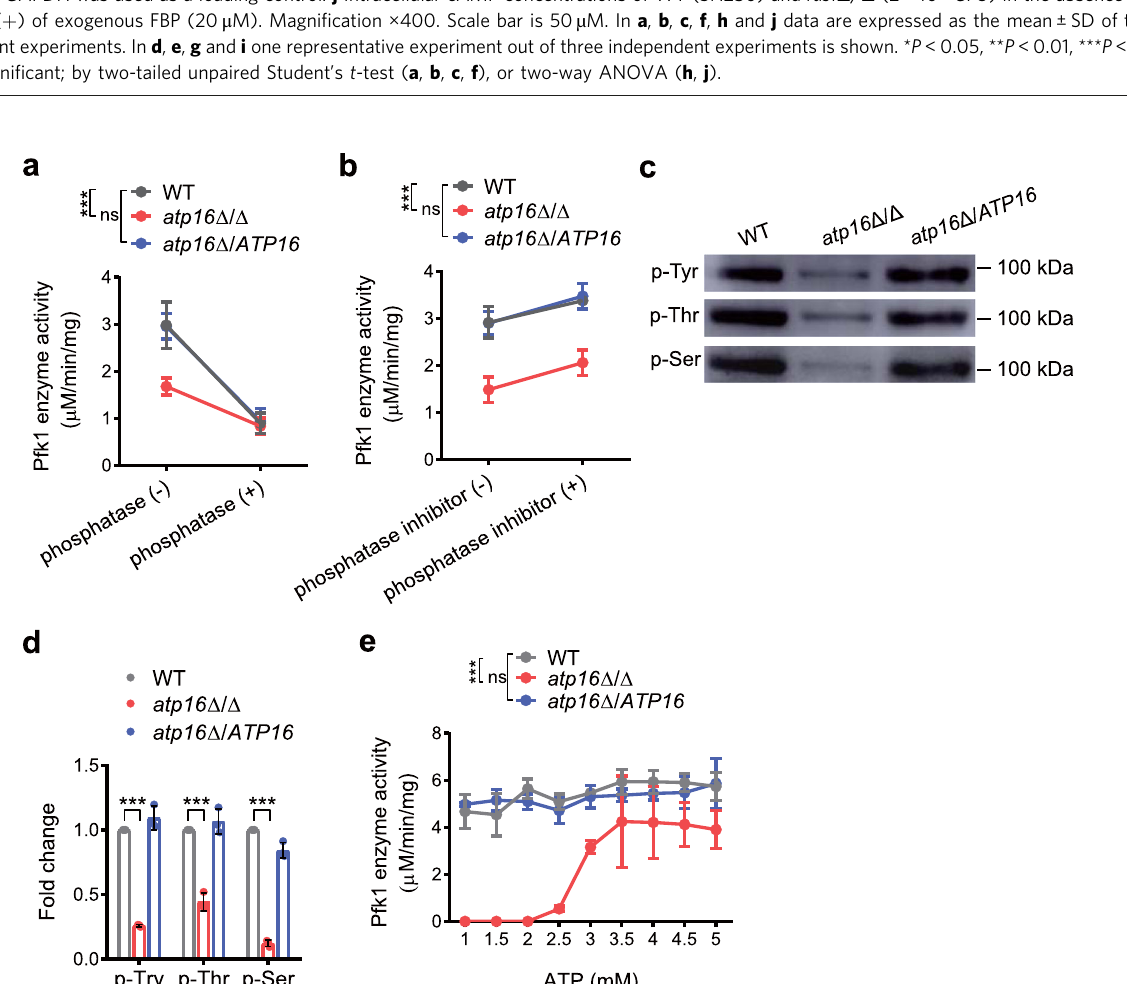
Fig. 6 Deletion of the δ subunit attenuates Pfk1 activity via dephosphorylation to perturb its conformation. a Pfk1 activity of WT, atp16 Δ / Δ and atp16 Δ / ATP16 in the absence ( − ) or presence ( + ) of alkaline phosphatase (2.5 U). b Pfk1 activity of WT, atp16 Δ / Δ and atp16 Δ / ATP16 in the absence ( − ) or presence ( + ) of phosphatase inhibitor (5 μ l). c Pfk1 phosphorylation levels were determined by immunoblotting after the enzymes puri fi ed by Af fi -gel blue and ion-exchange chromatography from WT, atp16 Δ / Δ and atp16 Δ / ATP16 with anti-phosphorylated tyrosine (p-Tyr) antibody, anti-phosphorylated threonine (p-Thr) antibody and anti-phosphorylated serine (p-Ser) antibody, respectively. d Quanti fi cation of Pfk1 p-Tyr, p-Thr and p-Ser phosphorylation in WT, atp16 Δ / Δ and atp16 Δ / ATP16 by densitometry. e The activity of Pfk1 puri fi ed by polymer-bound Cibacron Blue F3G-A and eluted with different concentrations of ATP. In a , b, d and e data are shown as the mean ± SD of three independent experiments. In c one representative experiment out of three independent experiments is shown. *** P < 0.001; ns, not signi fi cant; by two-way ANOVA ( a , b and e ), or two-tailed unpaired Student ’ s t -test ( d